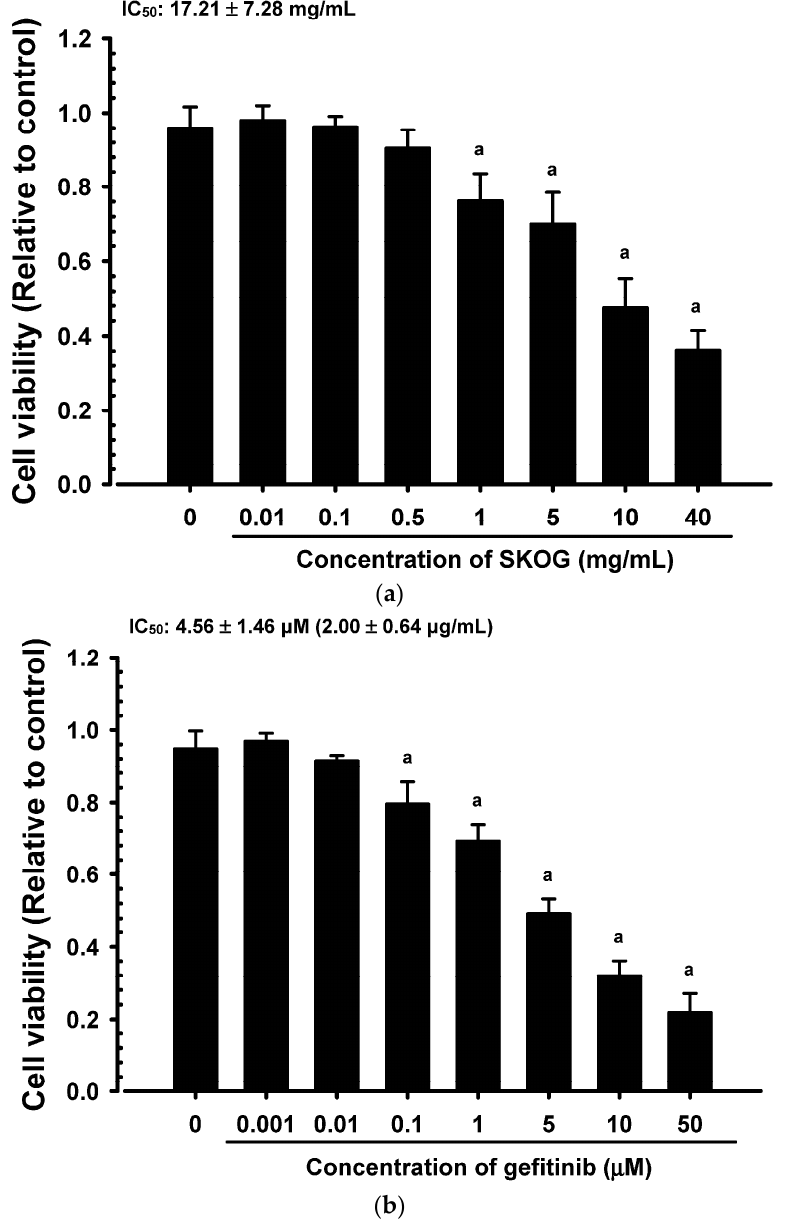
Figure 1. ( a ) Effects of SKOG on the NCI-H520 tumor cell viability. AR = Adenophorae Radix; KOG = Kyeongokgo ; SKOG = Sasam-Kyeongokgo . IC 50 = 50% inhibitory concentration. a p < 0.01 versus control (0 mg/mL), assessed by the Mann–Whitney U test. ( b ) Effects of gefitinib on the NCI-H520 tumor cell viability. IC 50 = 50% inhibitory concentration. a p < 0.01 versus control (0 μ M), assessed by the Mann–Whitney U test. Table 1. Changes in BW gain in NCI-H520 tumor cell xenograft